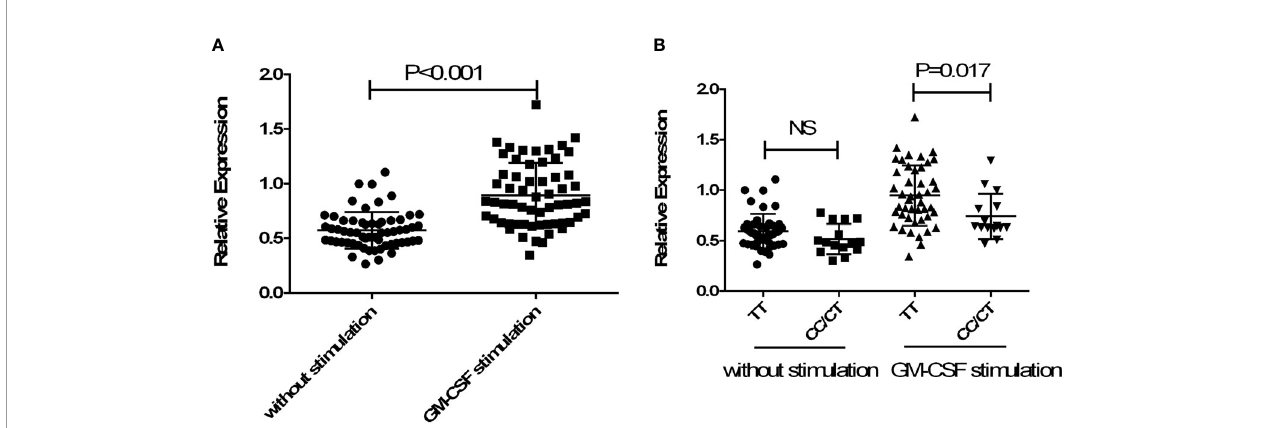
FIGURE 3 | Gene expression analysis of NFE2L2 in neutrophils. (A) Comparison of the mRNA expression level of NFE2L2 between GM-CSF stimulated and without stimulated human neutrophils. (B) Comparison of the effects of different genotypes of rs13005431 on the mRNA expression level of NFE2L2 in the GM-CSF stimulated group and unstimulated group. NS, No statistical